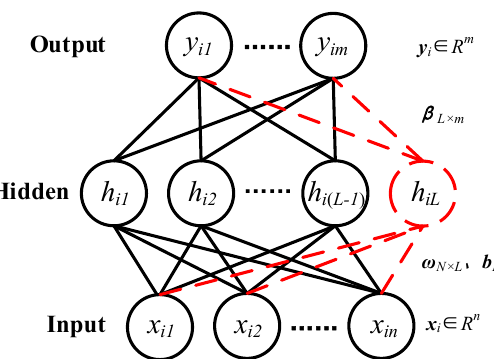
Figure 1. The structure of SCN network [18].